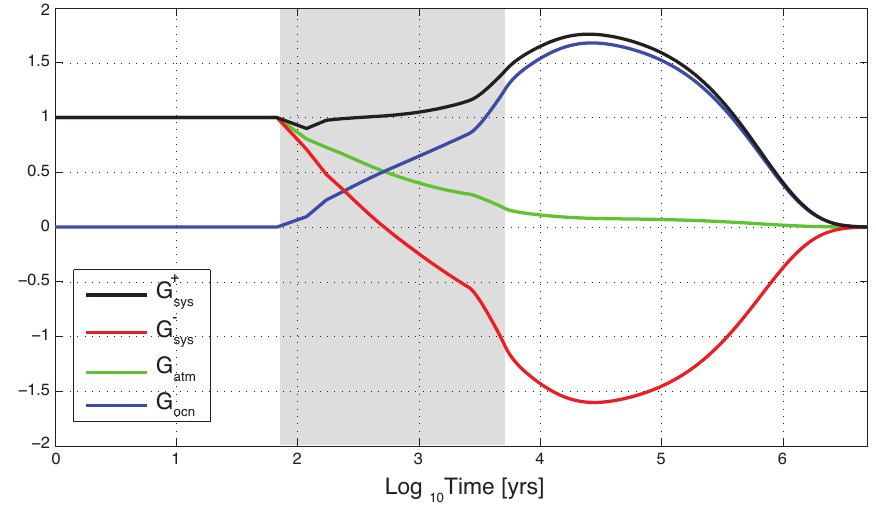
Figure 3. System gain factors as a function of time for the case of E = 1000PgC and D = 5kyr. Shaded region indicates time of